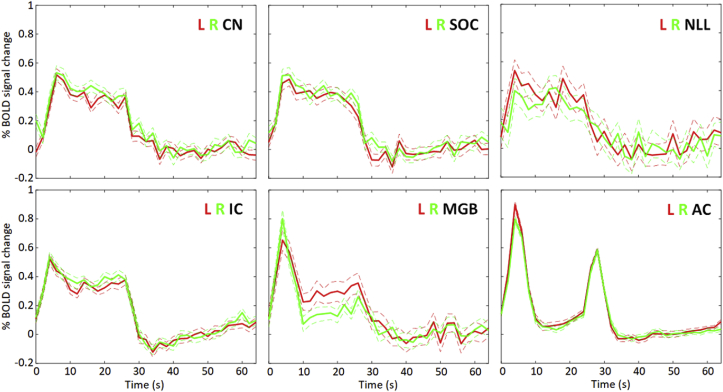
Group mean BOLD percentage change to broadband noise stimulation (all participants, n = 62) in the CN, SOC, NLL, IC, MGB and auditory cortex (AC). Dashed lines show standard error. Note the systematic variation in the fMRI response to the broadband noise stimulus epoch throughout the auditory pathway from one that is sustained over the stimulus epoch (CN, SOC, NLL, and IC) to one that is phasic at stimulus onset and offset (MGB, AC).